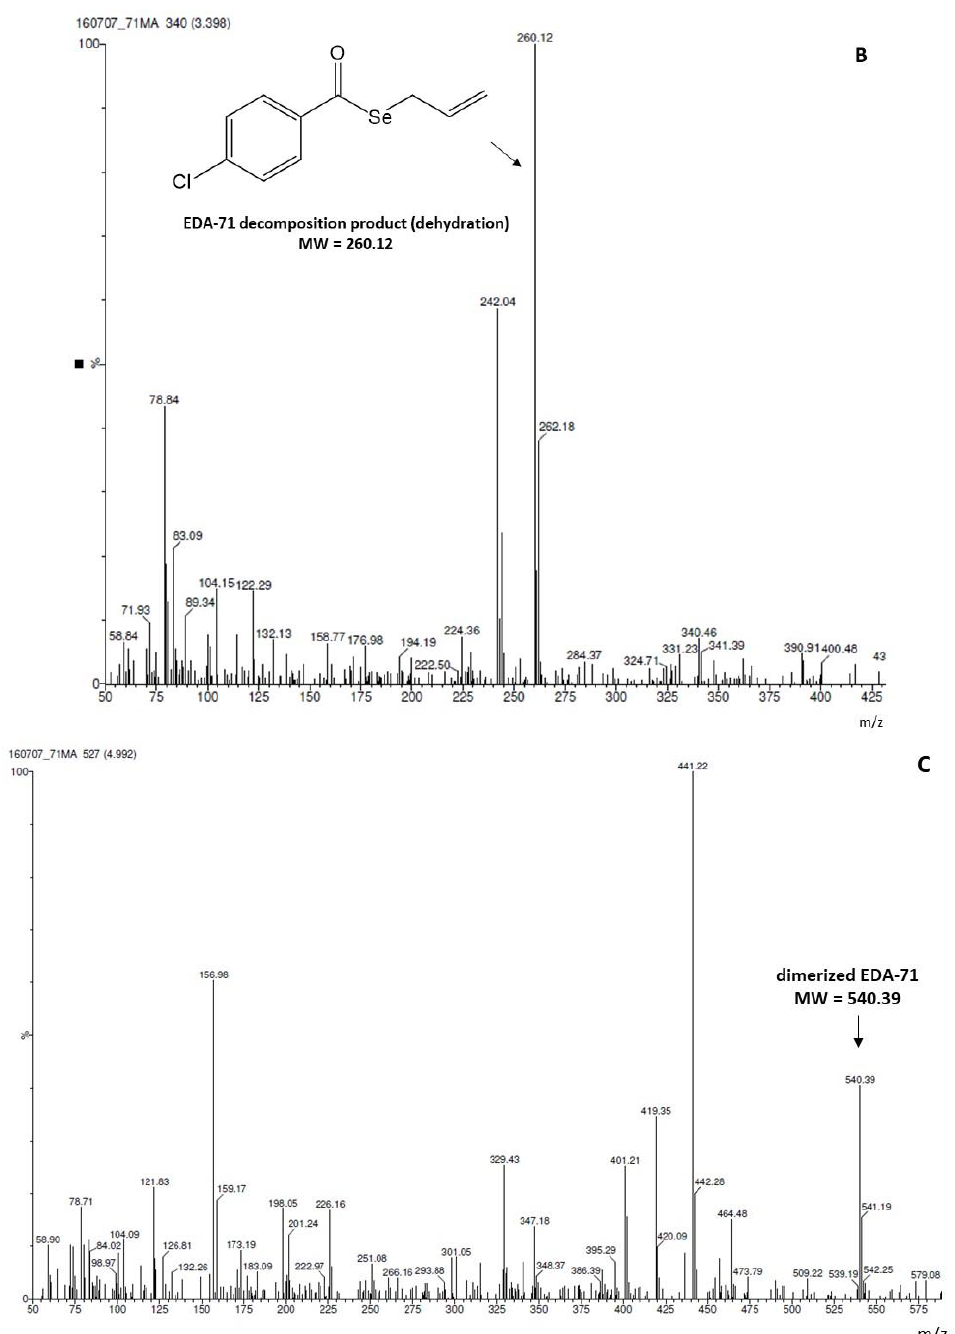
Figure 6. ( A ) The UPLC (ultra-performance liquid chromatography) spectra obtained after the incubation of EDA-71 with human liver microsomes. Like the control sample with TRIS buffer, it presented a dehydration product ( m / z = 260.12). Diode Array, range: 1.69 × 10 2 . ( B ) MS spectra obtained after the incubation of human liver microsomes with the EDA-71 selenoester. Like the control sample with TRIS, it showed a dehydration product ( m / z = 260.12). ( C ) MS spectra obtained after the incubation of human liver microsomes with the EDA-71 selenoester. Like the control sample with TRIS, it showed the EDA-71 dimer ( m / z = 540.39).